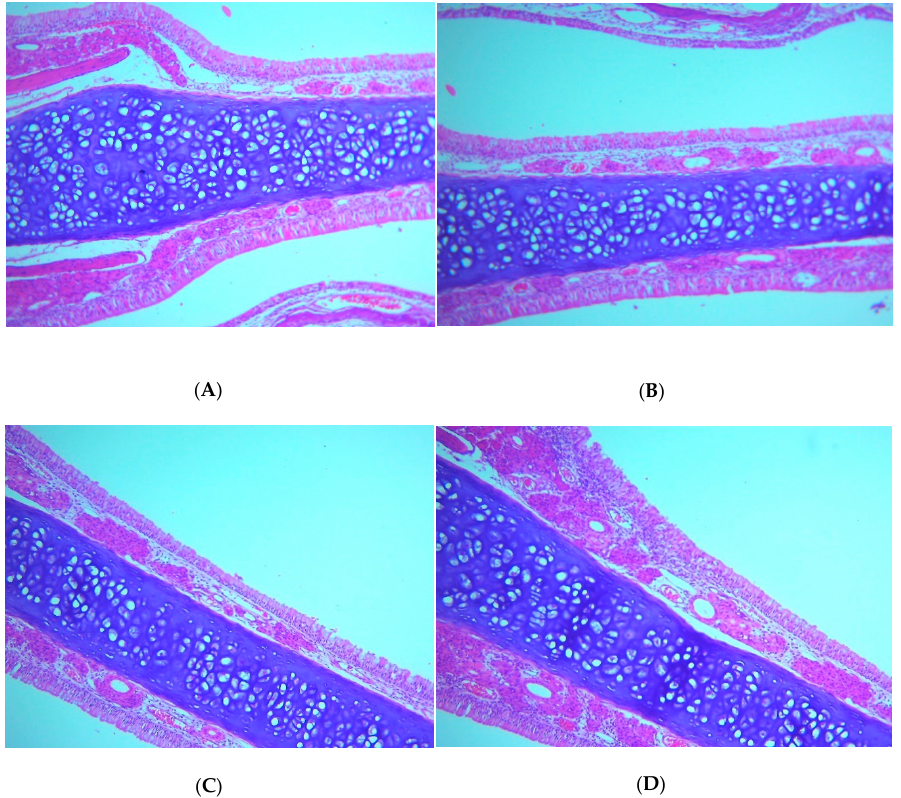
Figure 6. Histopathological results for ( A ) untreated rats (gp1), ( B ) rats treated with plain hydrogel (gp2), ( C ) rats treated with raw FLB loaded in hydrogel (gp3), and ( D ) rats treated with optimized FLB-TRF hydrogel (gp4), showing normal nasal wall with normal intact epithelial lining (black arrow), average submucosa with average blood vessels, average submucosal cellularity (yellow arrow), and average nasal cartilage (white arrow) (H&E, 200× magnification), all of which indicate no increase in submucosal cellularity or tissue abnormality.